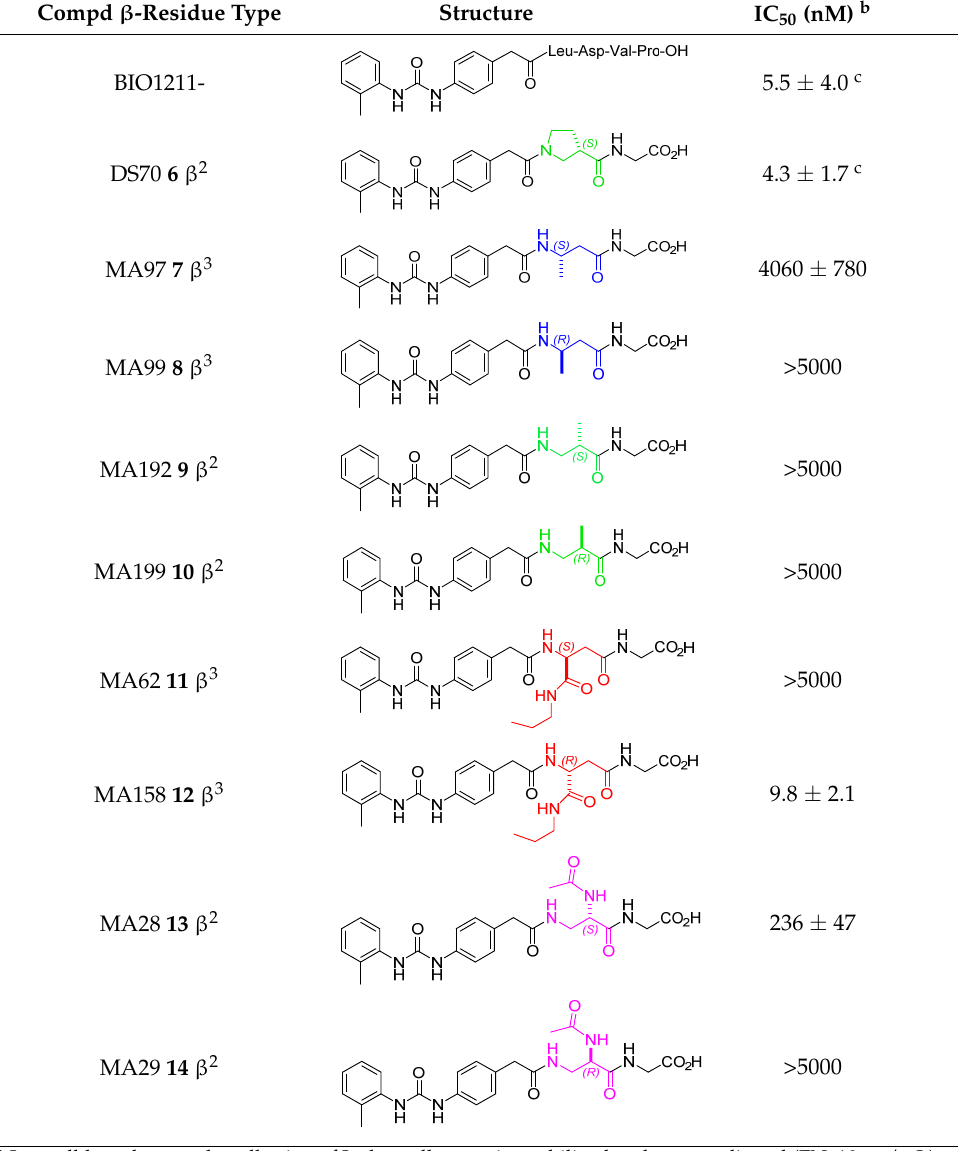
Table 1. Inhibition of α 4 β 1 integrin-mediated Jurkat cell adhesion a to plates coated with the endogenous ligand FN (10 µ g/mL) by the reference compounds BIO1211 and DS-70 ( 6 ), and by the new hybrid peptides 7 – 14 .